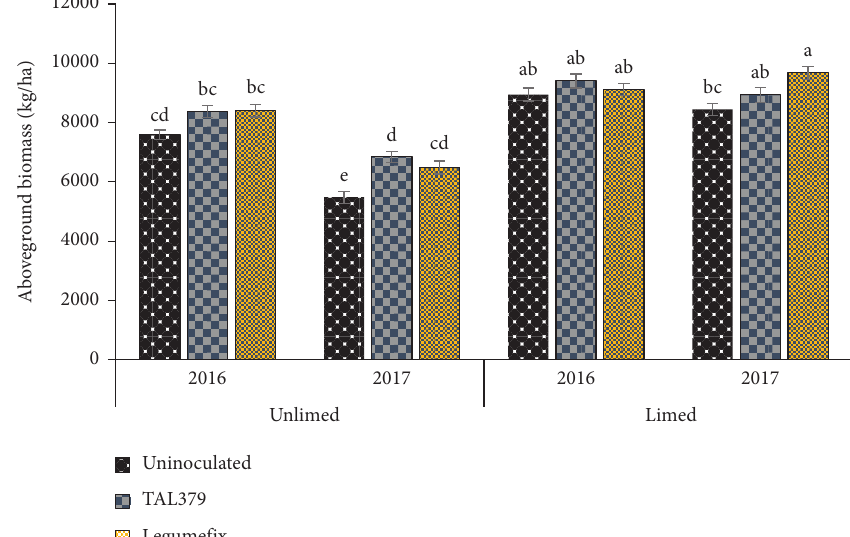
Figure 4: Interaction of effect of Bradyrhizobium strains and lime rates on the aboveground biomass yield. Bars followed by similar letters are not significantly different to each other at LSD